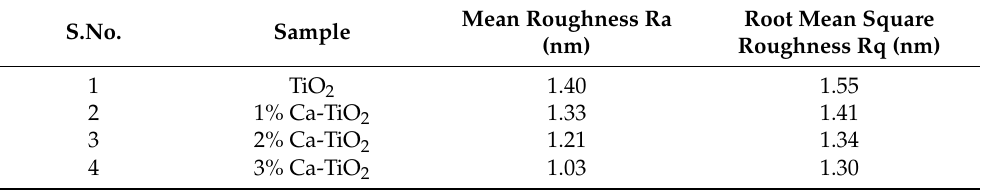
Table 2. Mean roughness (Ra) and root mean square roughness (Rq) of prepared ETL. S.No.